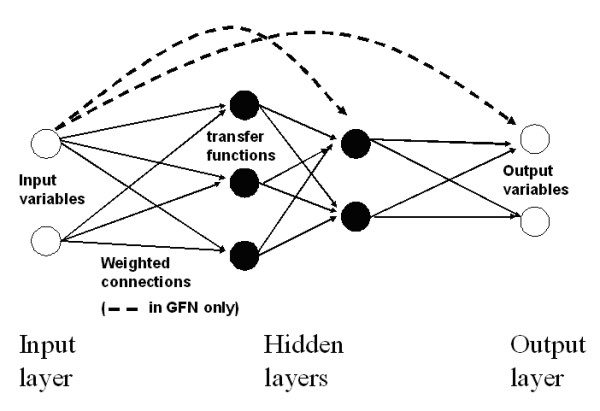
Schematic representation of an artificial neural network. A typical ANN consisting of one input layer, two hidden layers and one output layer is represented. The basic structure, fed forwards and trained by back-propagation is called Multilayer Perceptron (MLP) while models designed with connections jumping over hidden layers (---) are called Generalized Feedforward Networks (GFN).